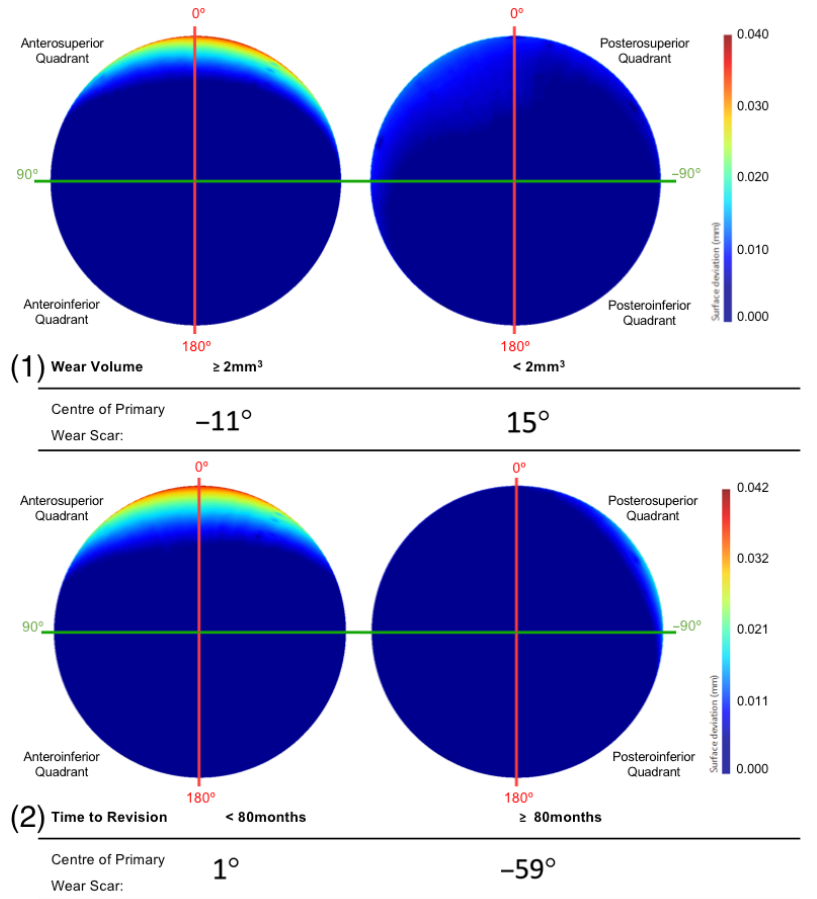
Figure 8. The mean surfaces generated following the subdivision of the acetabular surface, based on their (1) volumetric were and (2) time to revision. This is presented as deviation maps of their comparison with the as-manufactured reference surface (mm).